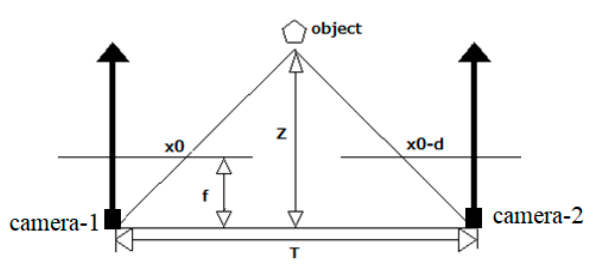
Figure 4. The positions of the cameras to determine the distance to the object: d is a value called disparity / o ff set, T is the distance between the cameras, Z is the distance to the object, and f is the focal length camera ratio.